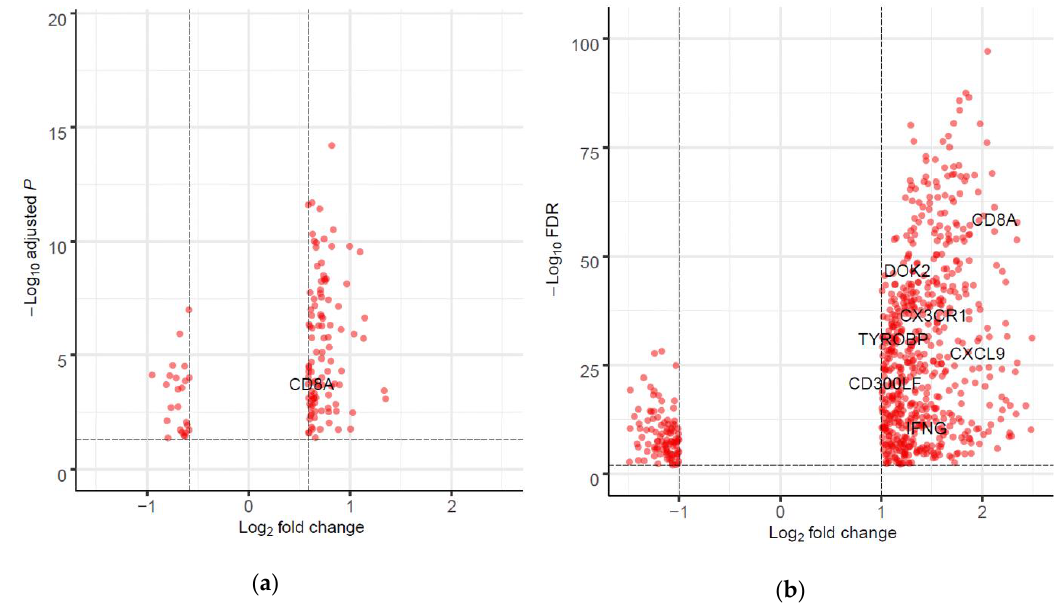
Figure 3. Volcano plots of all di ff erentially expressed genes (DEGs) between tumors with high and low CD200R1 expression. ( a ) DEGs in GEO dataset. Red points represent genes with a | fold change | of > 1.5 and adjusted p -values of < 0.05. Dotted horizontal line indicates an adjusted p -value of < 0.05. Dotted vertical line indicates a | fold change | of > 1.5. ( b ) DEGs in TCGA dataset. Red points represent genes with a | fold change | of > 2.0 and a false discovery rate (FDR) of < 0.01. Dotted horizontal line indicates an FDR < 0.01. Dotted vertical line indicates a | fold change | of > 2.0.